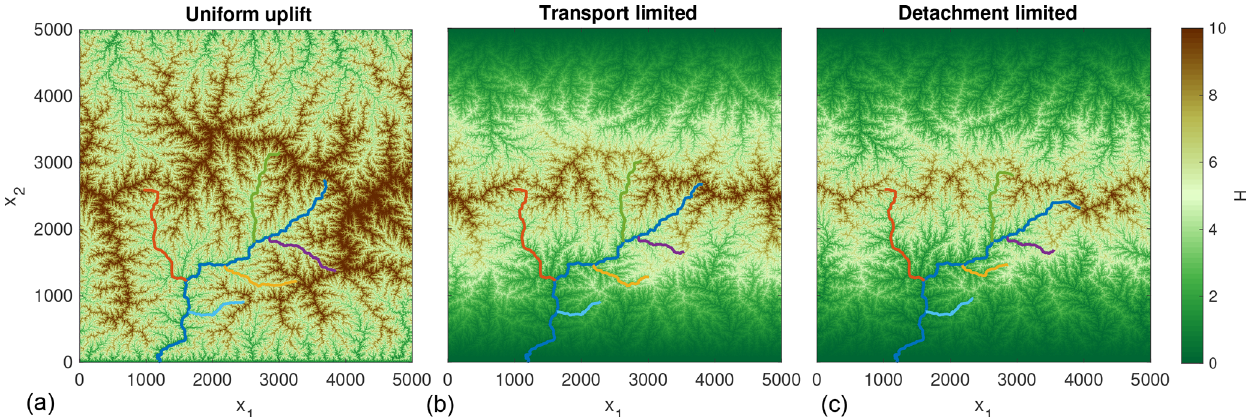
Figure 2. Equilibrium topographies for uniform uplift (a) and for a tent-shaped uplift pattern (b, c) . The color-coded rivers are the largest stream and its five largest tributaries in the topography for uniform uplift. They are referred to in Fig. 4.